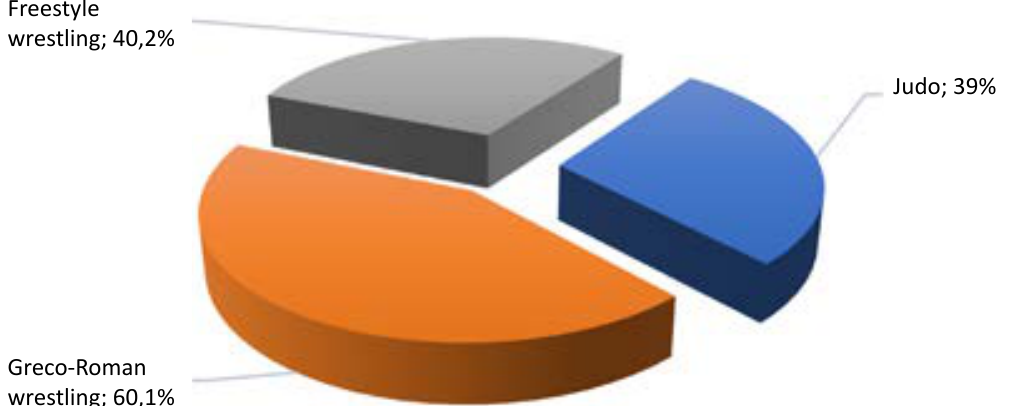
Fig. 2. General level of functional fitness (%) in highly skilled wrestlers of different specialization (freestyle and Greco- Roman wrestling,